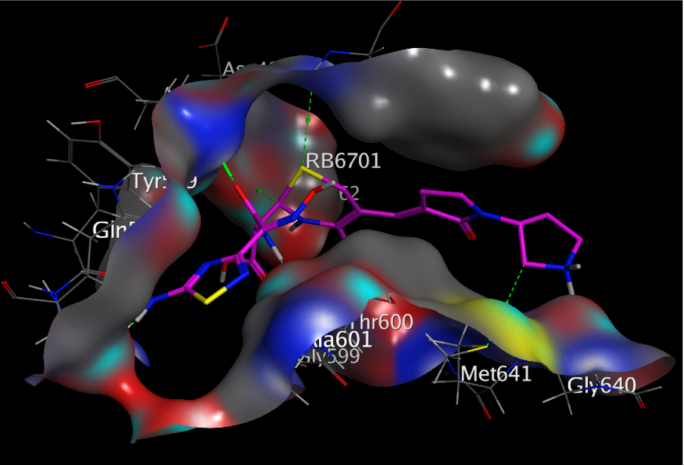
Figure 7. Co-crystallized ligand (RB6) represented as pink sticks re-docked in the receptor active site. Table 9. Molecular modeling data regarding binding affinity, RMSD values and receptor residues involved in